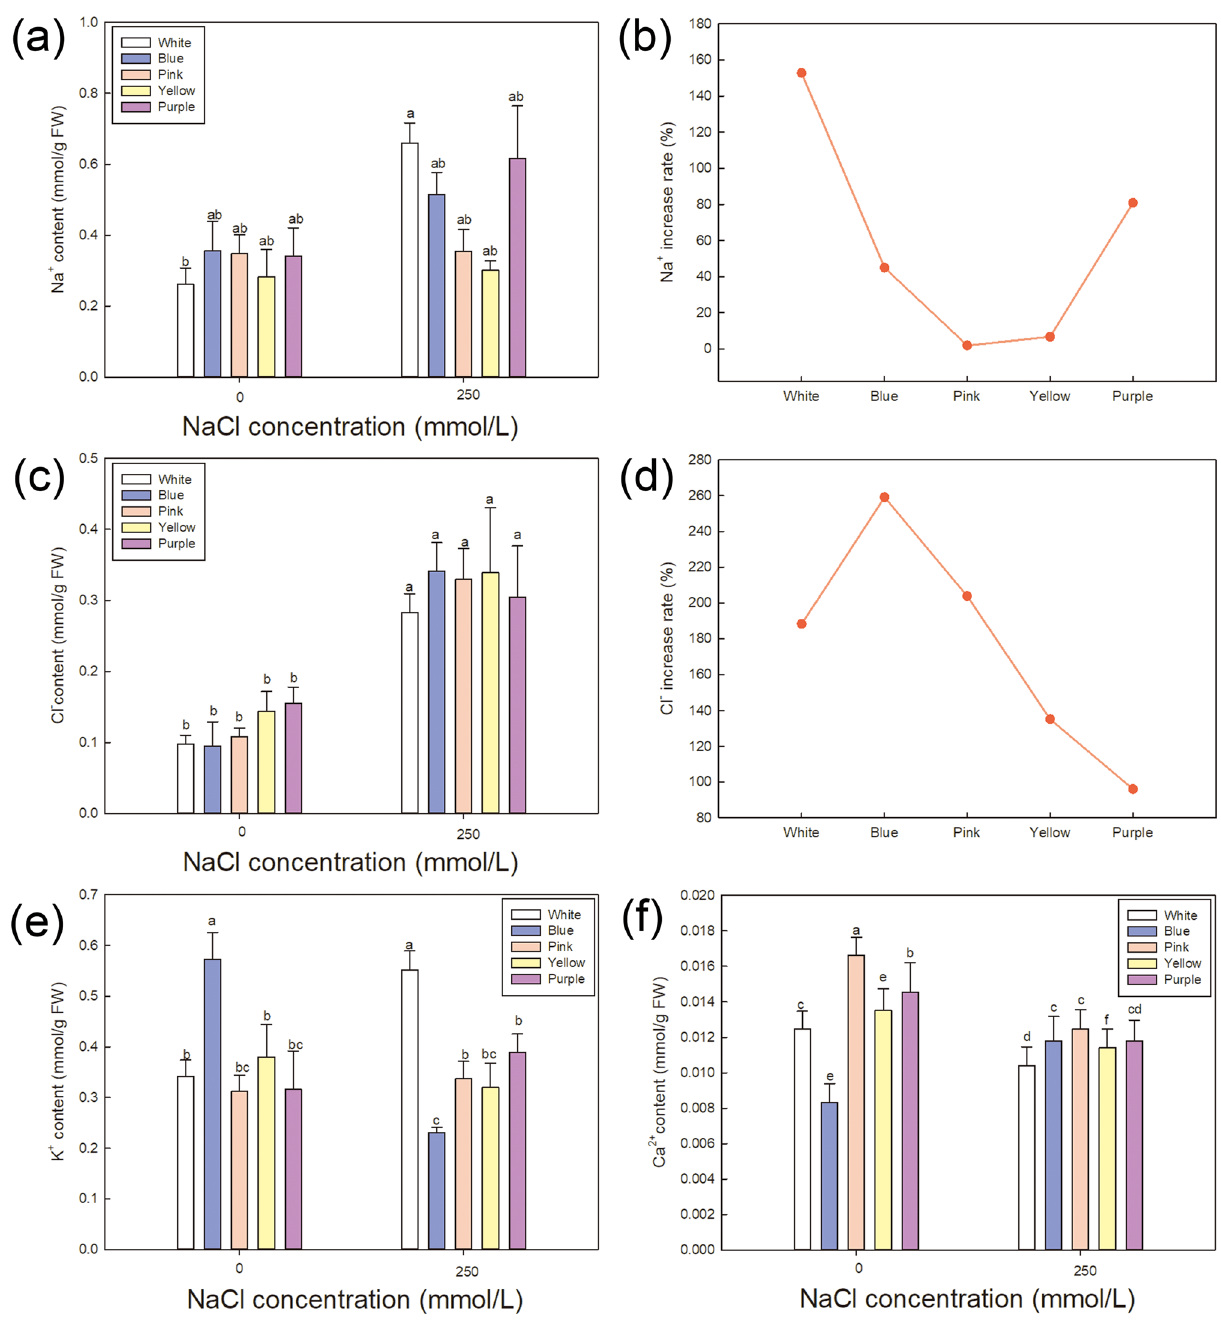
Figure 5. Effect of NaCl treatment on Na + , K + , Ca 2+ , and Cl − contents. Contents of Na + ( a ), Cl − ( c ), K + ( e ) and Ca 2+ ( f ) under control and NaCl treatment in different varieties. The data are means ± SD of five replicates. Different letters indicate significant differences between two groups at P = 0.05 using Duncan’s test with SPSS. ( b , d ) The increase rate of Na + and Cl − under NaCl treatment in five varieties, which was calculated as (ion contents under NaCl treatment—ion contents under control)/ion contents under control ×